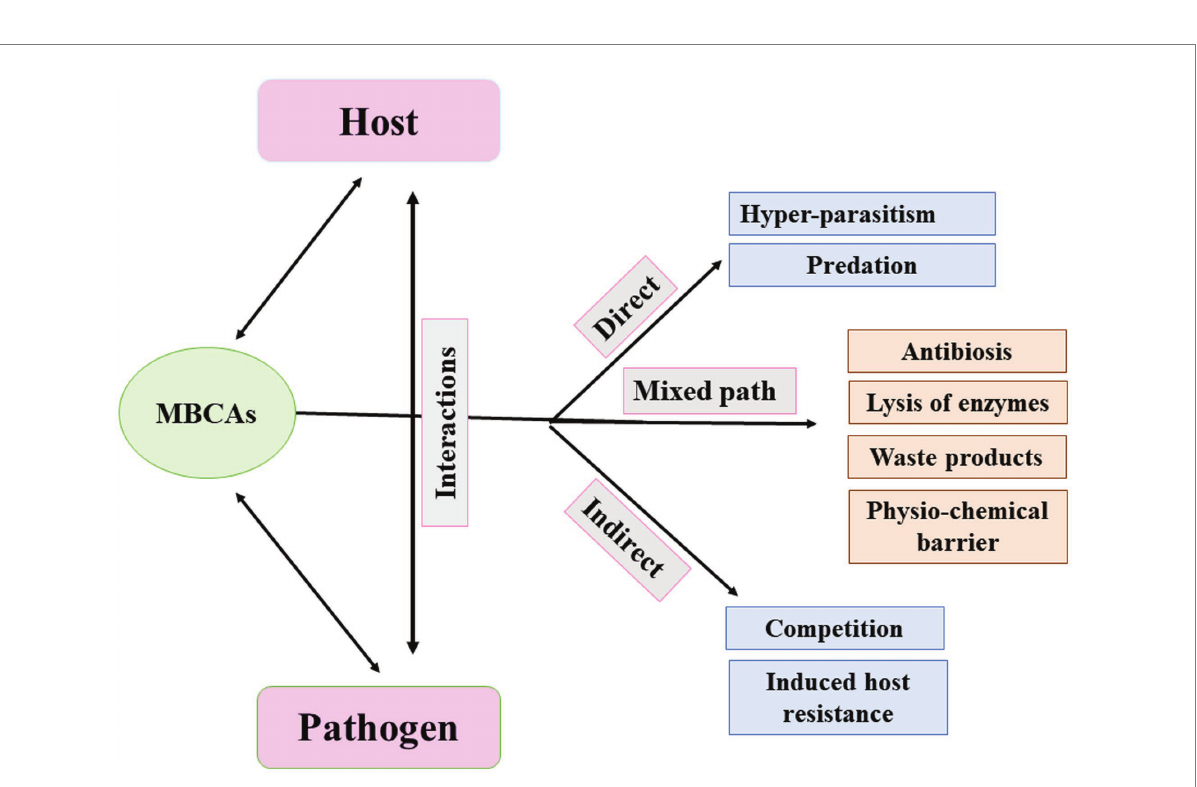
FIGURE 3 Pathways of microbial biocontrol agents (MBCAs).